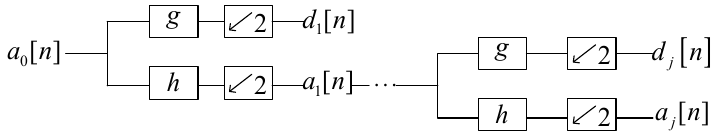
Figure 3. Orthogonal wavelet decomposition. After wavelet transformation, SVD is used to distinguish signals of different frequency bands; this can be applied to decompose non-square matrices, and it is assumed